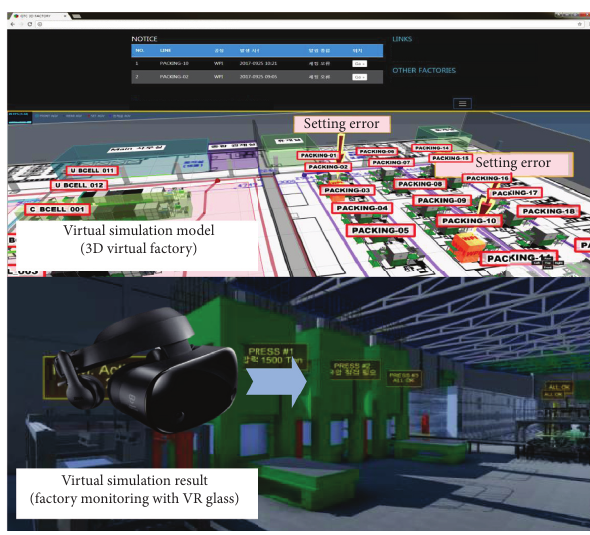
Figure 5: Application of virtual simulation in smart manufacturing.